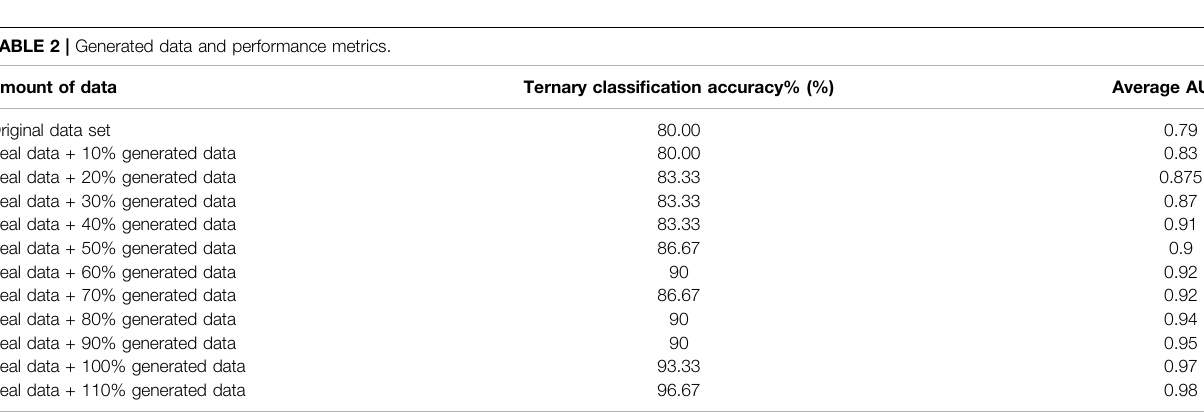
TABLE 2 | Generated data and performance metrics.